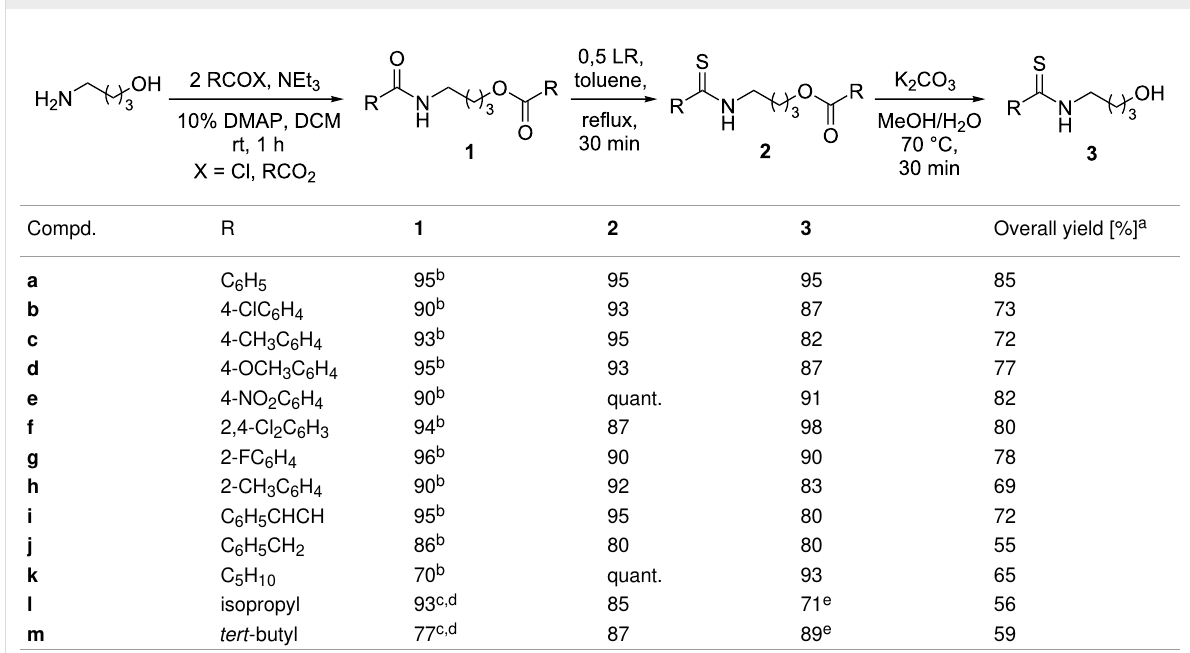
Table 1: Synthesis of compounds 3